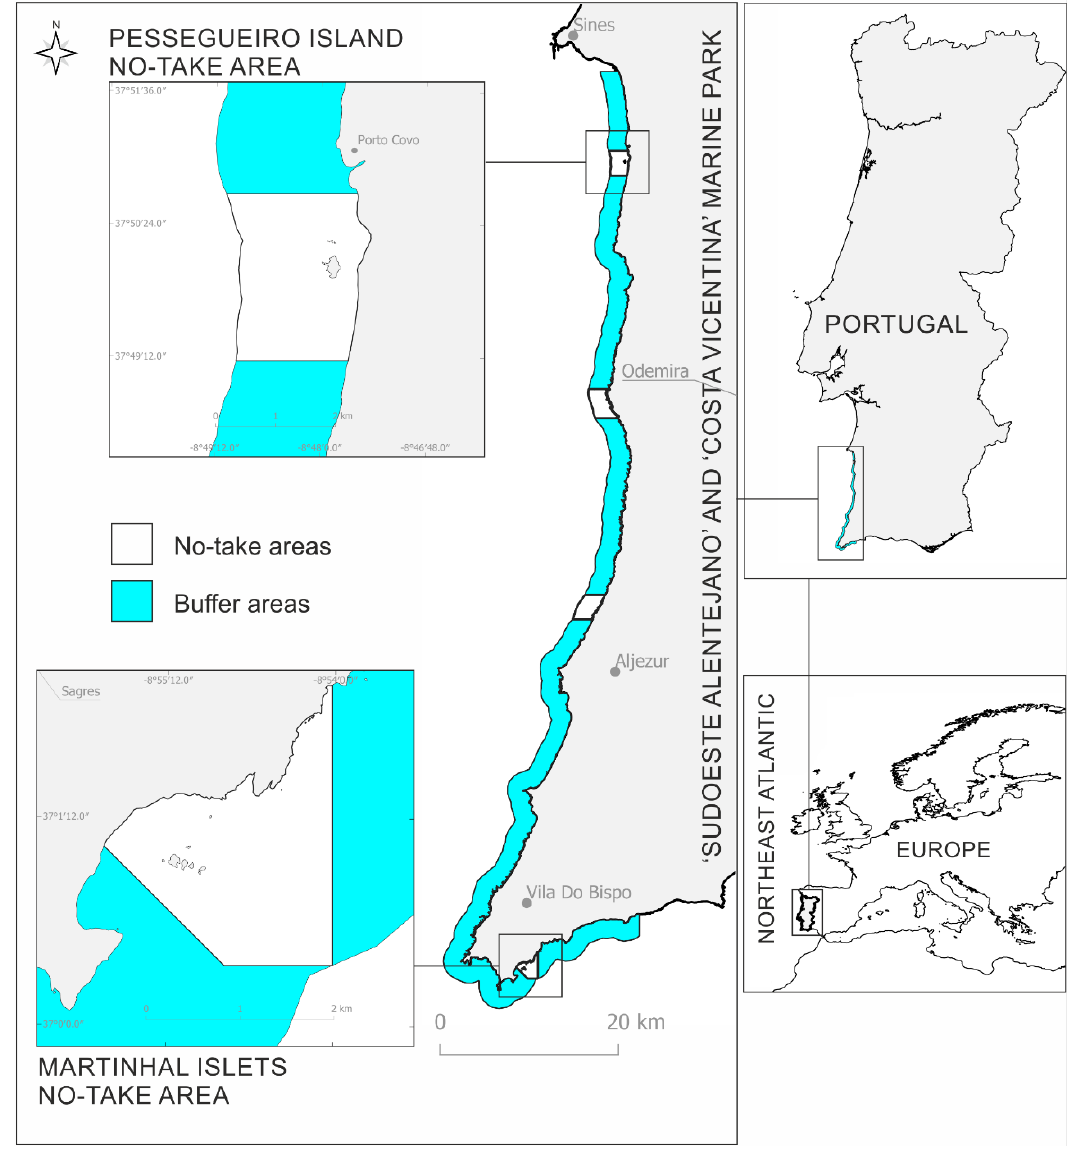
Figure 1. Location of the ‘Sudoeste Alentejano’ and ‘Costa Vicentina’ Marine Park and the two no-take areas — Pessegueiro island and Martinhal islets no-take areas.